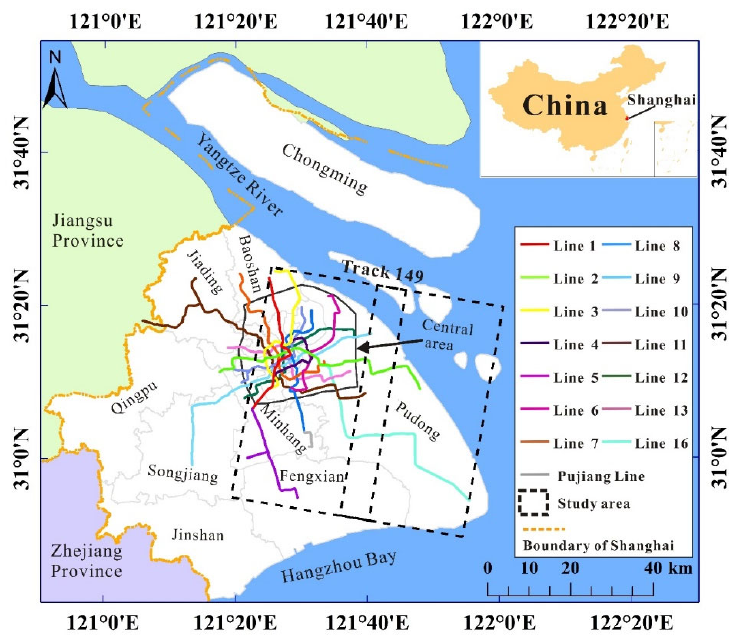
Figure 1. The geographical location of Shanghai, the position of subway lines, and the study area in Shanghai.